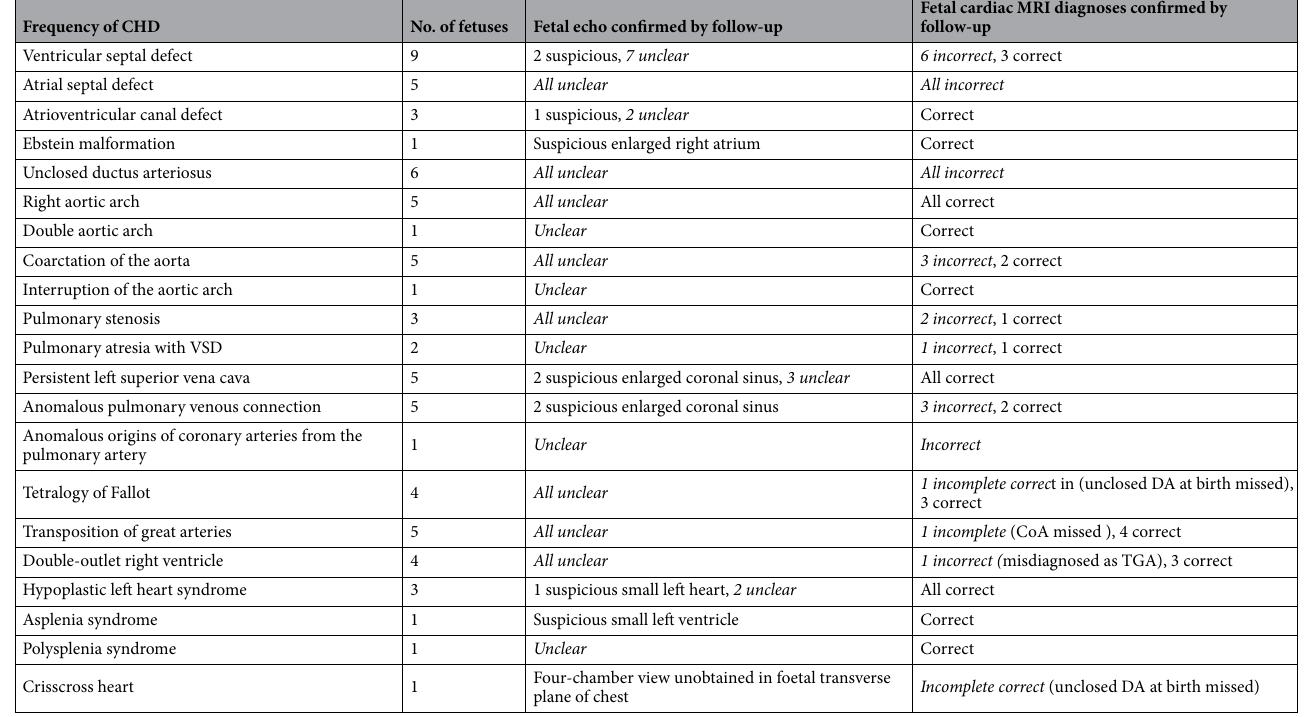
Table 3. Frequency of confirmed 71 fetal congenital heart diseases (CHDs) and comparison of the diagnoses between fetal heart magnetic resonance imaging (MRI) and